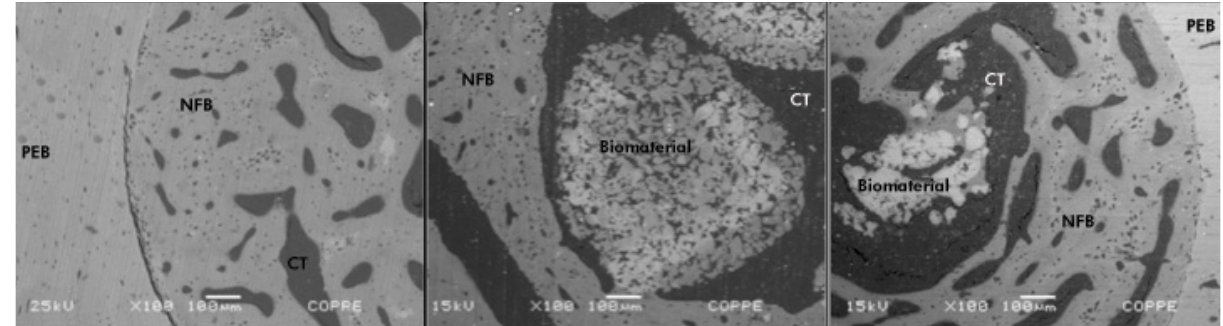
Figure 6. Scanning electron microscopy (SEM) micrographs. (A) Control group; (B) HA group; (C) SrHA group. NFB: newly formed bone; PEB: pre-existing bone; and CT: connective tissue; magnification: 100X.